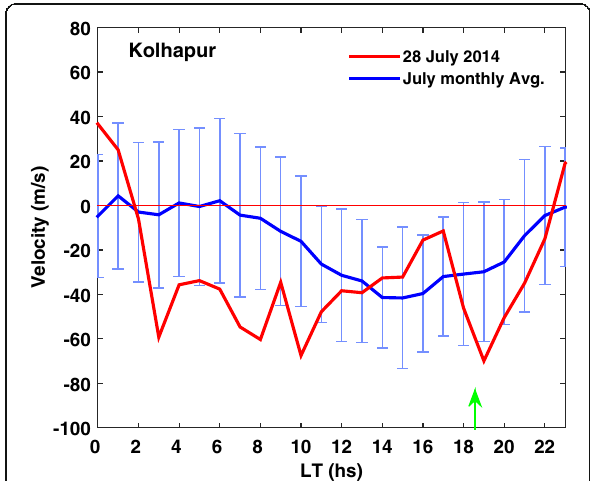
Fig. 6 The mesospheric meridional wind (positive northward) as a function of local time on 28 July 2014 (red line) and 30-day average (July 28 ± 15 days) centered on July 28 (blue line with error bar) observed by MF radar at Kolhapur. The small vertical green arrow indicates the time of equatorial E-region (100 km) sunset over